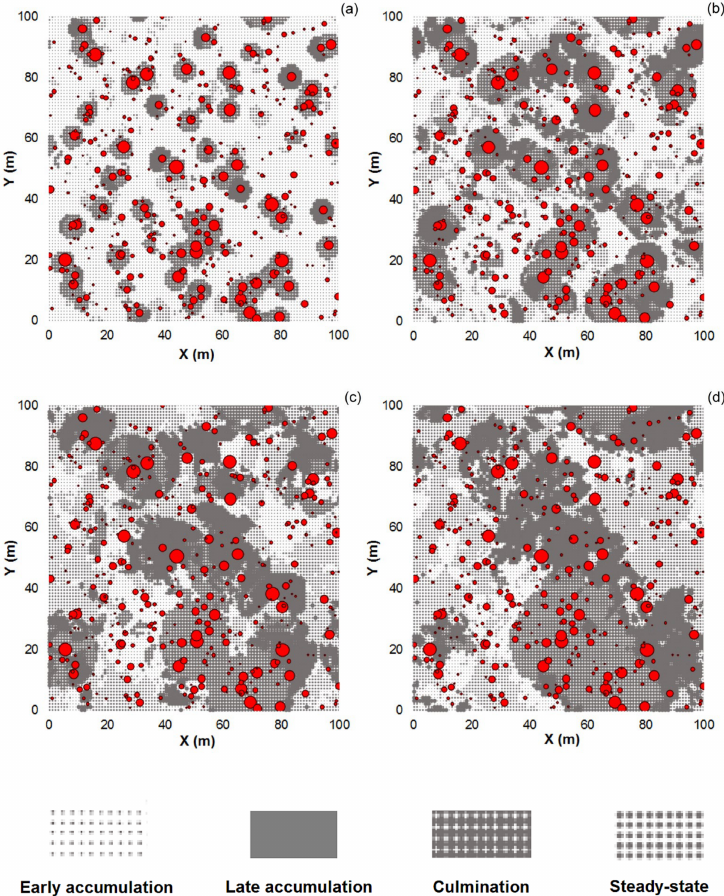
Figure 2. Raster models of patch classification dependent on the moving window size (original classification without smoothing). The classification outputs were assigned to the center cells of the sliding circular windows with diameters of 10 ( a ), 15 ( b ), 25 ( c ), and 35 m ( d ) and the moving distance of 1 m. The points represent randomly distributed trees in the model stand: stem density of 500 ha − 1 , basal area of 37 m 2 ha − 1 , a negative exponential dbh distribution, and dbh range between 7 and 90 cm. The point size is proportional to the tree